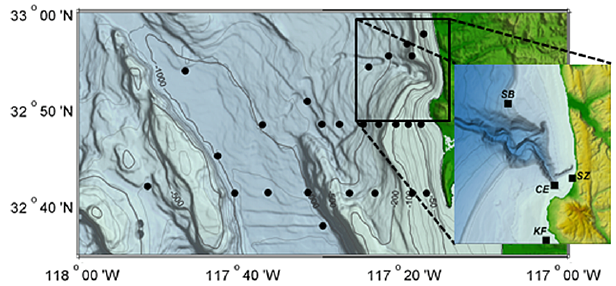
Figure 1. Map of study region. Hydrographic stations (black dots) and sensor deployment sites (black squares) are shown. Initials are as follows: CE, canyon edge; SB, shelf break; SZ, surf zone; and KF, kelp